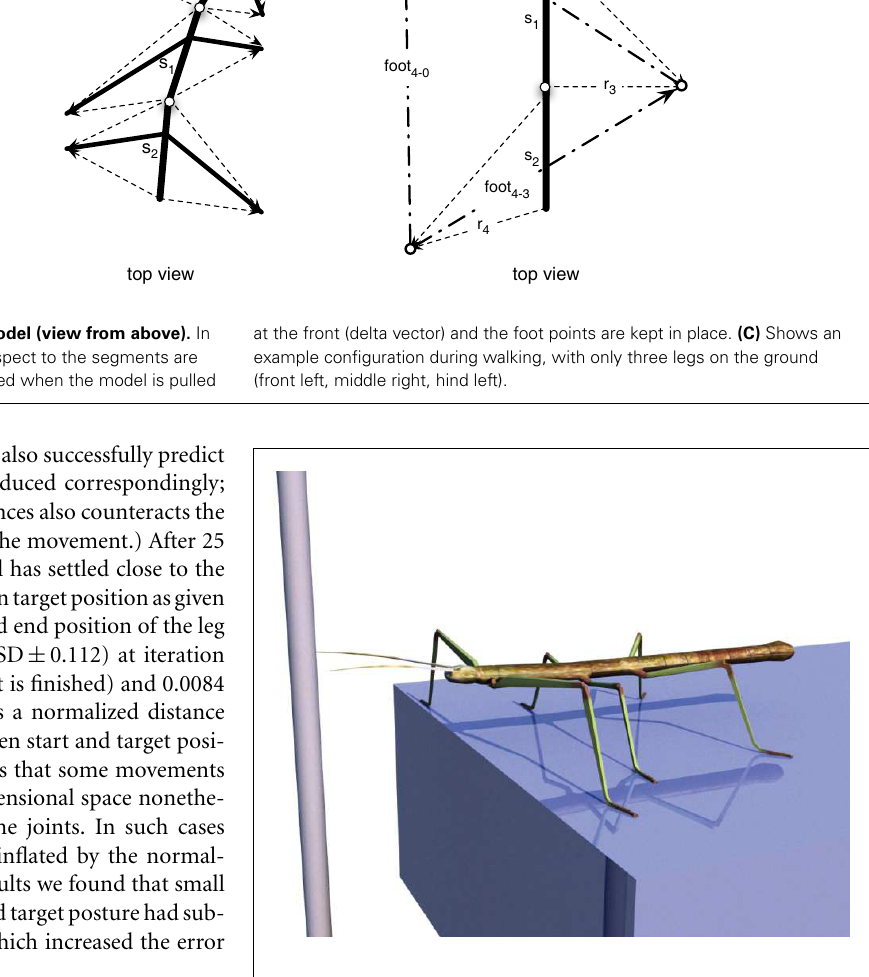
FIGURE 5 | Insect in front of a gap. Left front leg will perform a searching movement that is controlled by the Swing-net.The leg network can be used in this case to estimate the end position of the leg (forward